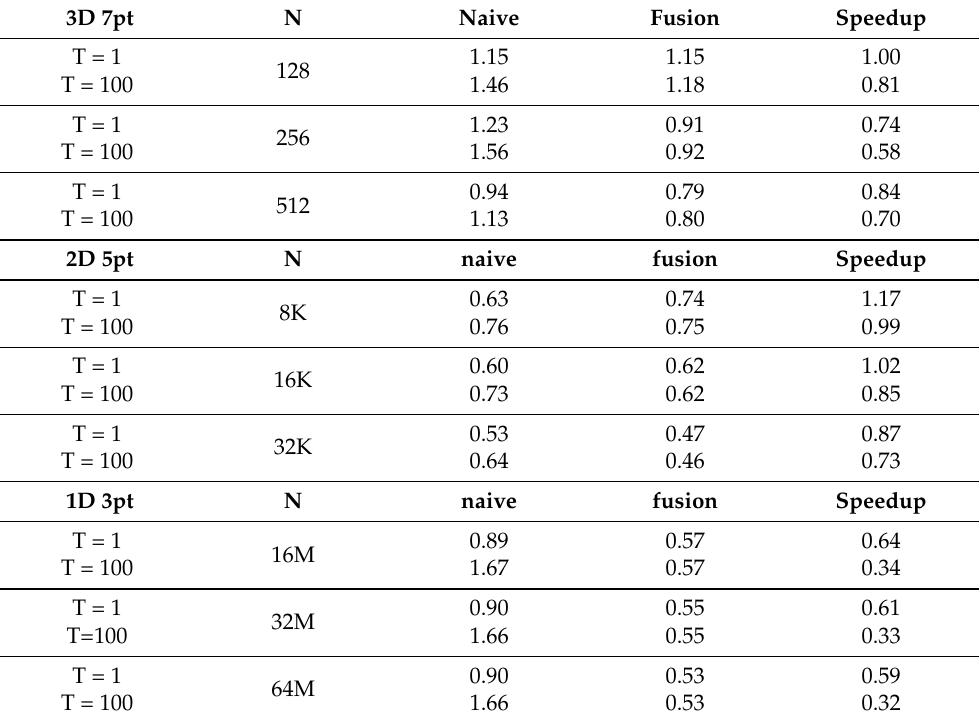
Figure 8. Experimental results of the proposed transformation recipes: (d) compound recipes (Intel). Table 3. Experimental results of the proposed transformation recipes: (e) loop fusion (ARM).